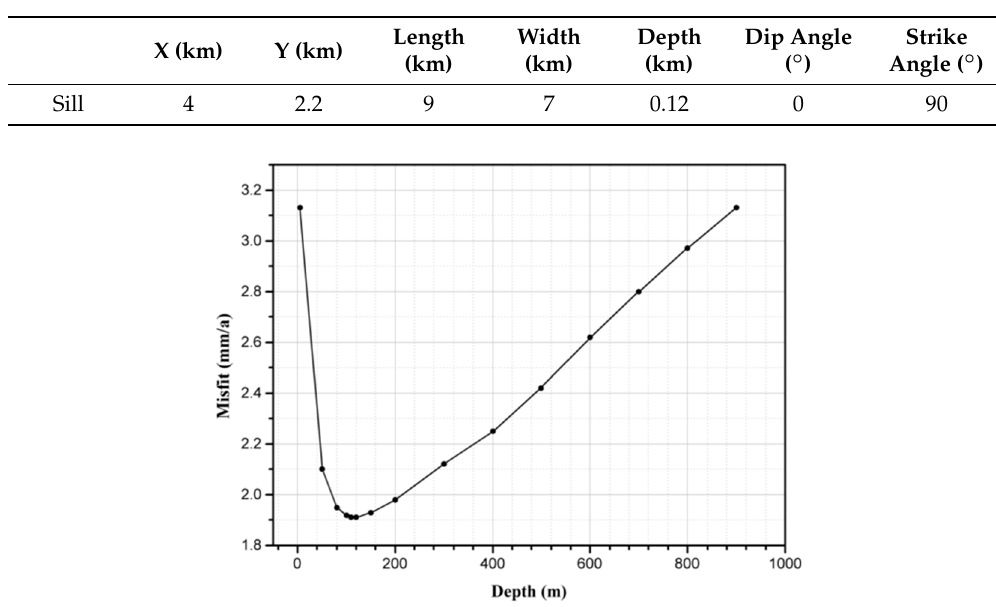
Figure 12. The variations of root mean square (RMS) of misfit with the depth of the flat-lying sill (black dots).